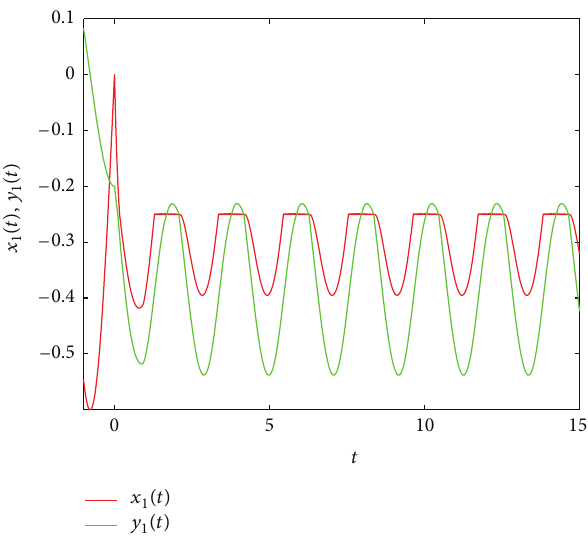
Figure 1: Time-domain behavior of the state variables 𝑥 1 (𝑡) and (𝑡) with 𝑢 (𝑡) = 0 . 𝑦 1 𝑖